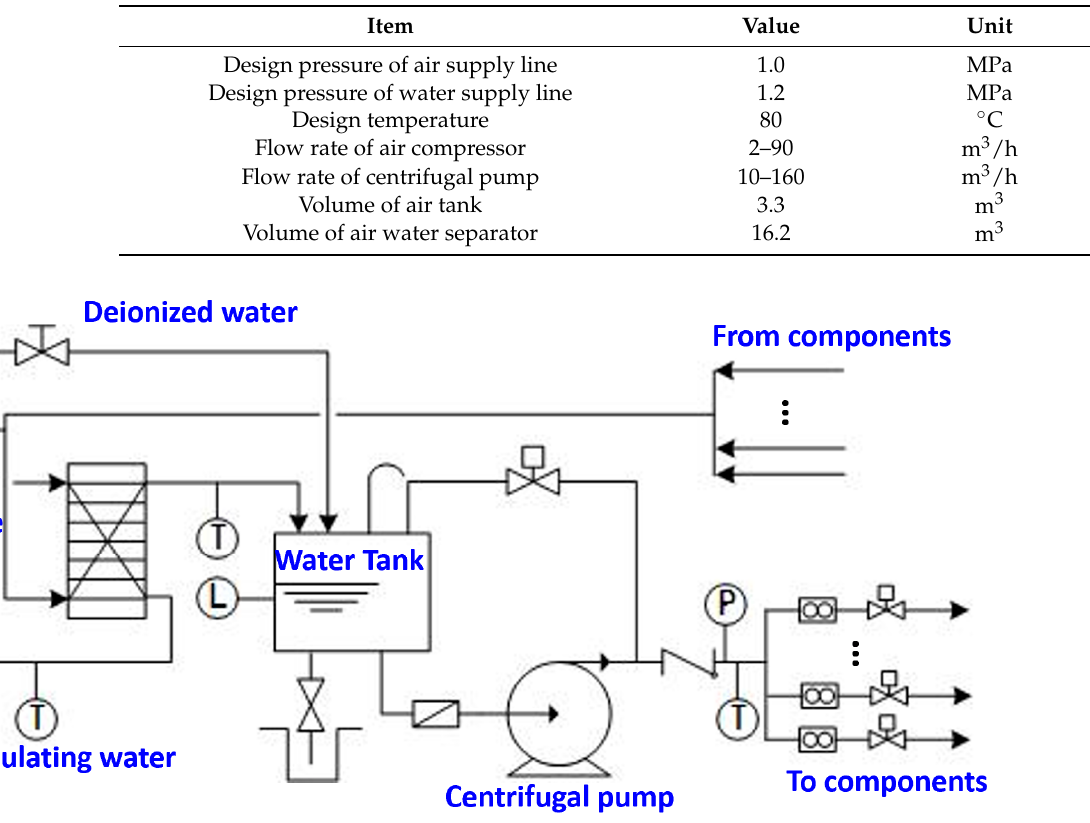
Figure 8. Scheme of the component cooling water system. Table 5. Design parameters of the component cooling water system.